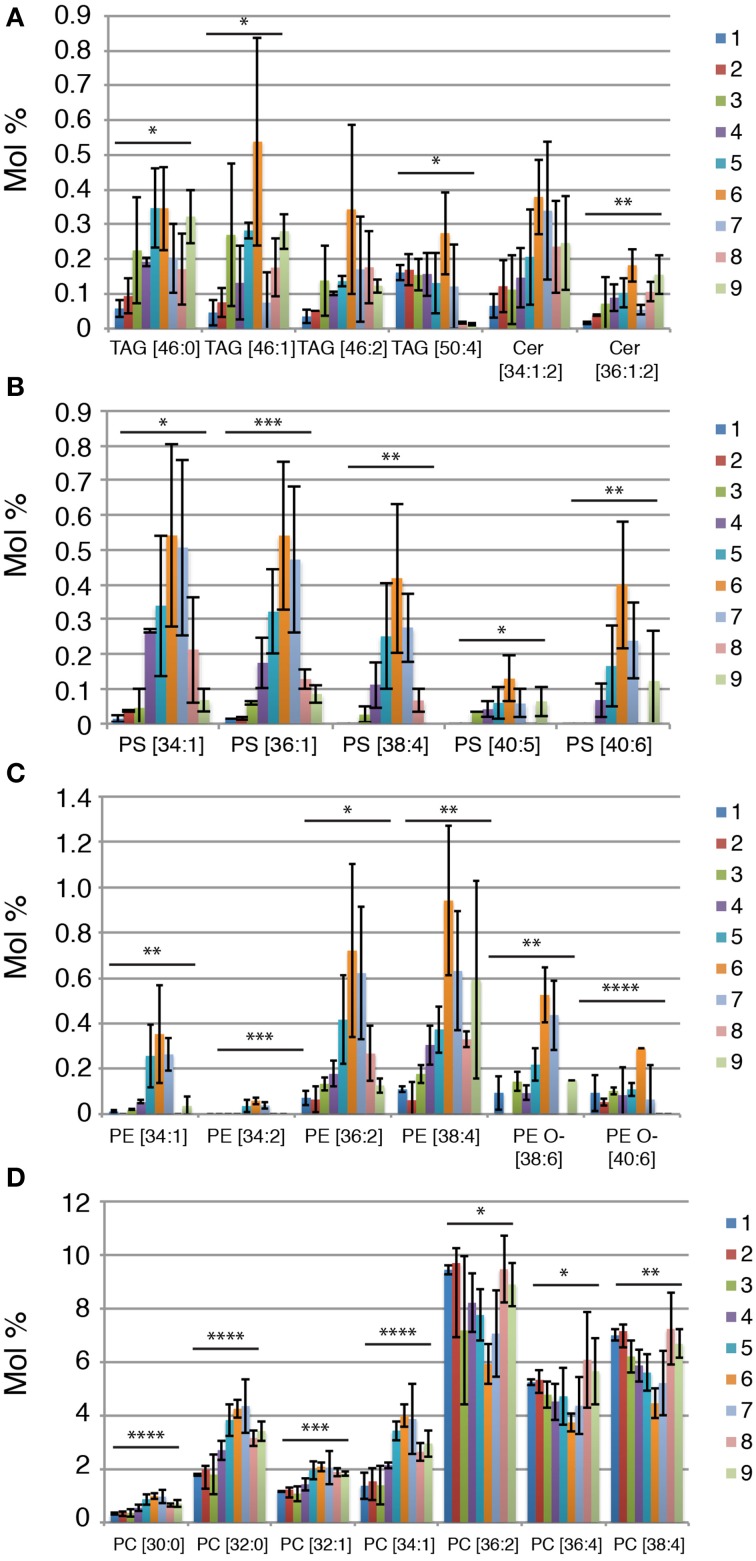
Lipid species that correlate with the presence of NE midbodies. (A–D) Lipid species relative abundance (mol %) across the sucrose fractions. Each lipid species is shown as the sum of number of carbon atoms and double bonds present in the long chain base and/or fatty acids. P-values were estimated by One-Way ANOVA; *P < 0.05, **P < 0.01, ***P < 0.001 and ****P < 0.0001. Error bars correspond to SD (n = 3).